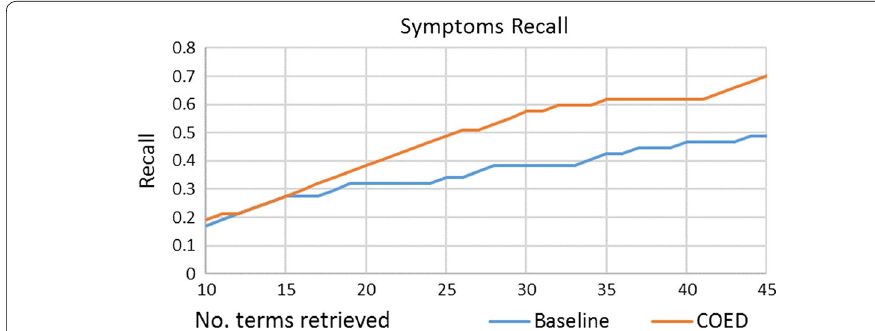
Fig. 9 Comparison of symptoms recall for baseline and COED methodologies